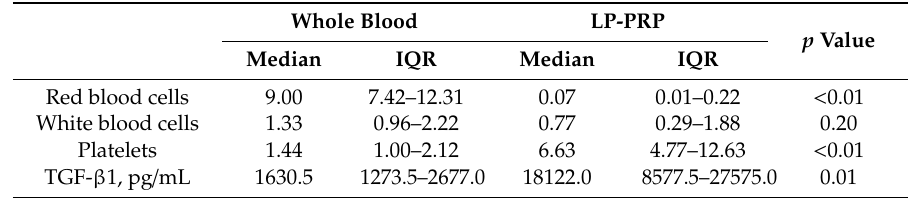
Table 2. Leukocyte-poor platelet-rich plasma (LP-PRP) complete blood count (CBC) and transforming growth factor-beta 1 (TGF- β 1) concentrations. Red blood cells were measured in M/mL, while white blood cells and platelets were measured in K/mL.